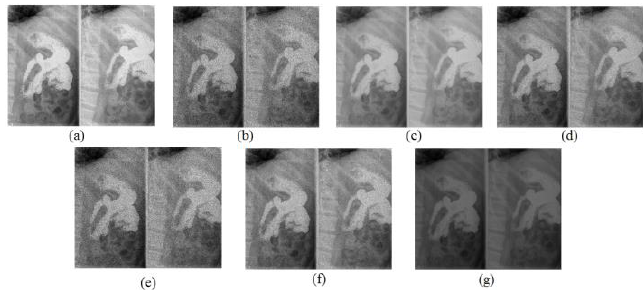
Figure3: (a) Original fluoroscopy image, (b) Noisy image, Denoised images by: (c) PURE-LET, (d) MS-VST, (e) Exact unbiased inverse of the VST, (f) Total variation, (g) PDE-based method.